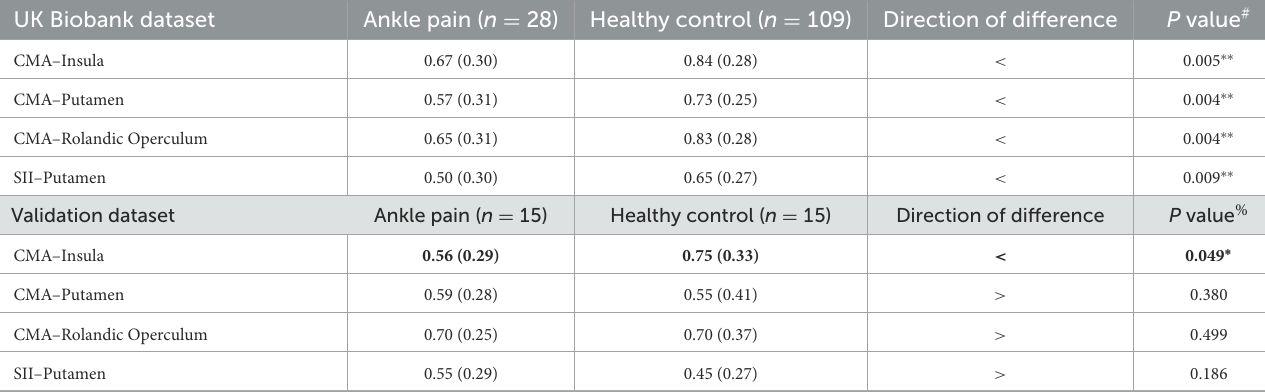
TABLE 3 Comparison of functional connectivity between the group chronic ankle pain and healthy control in two parts of study. UK Biobank